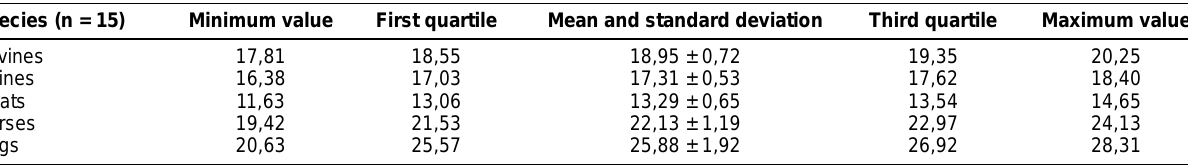
Table-2. Terminal values, averages, standard deviation and quartiles of the circumference of red blood cells of pets (expressed in µm). Species (n = 15) Bovines